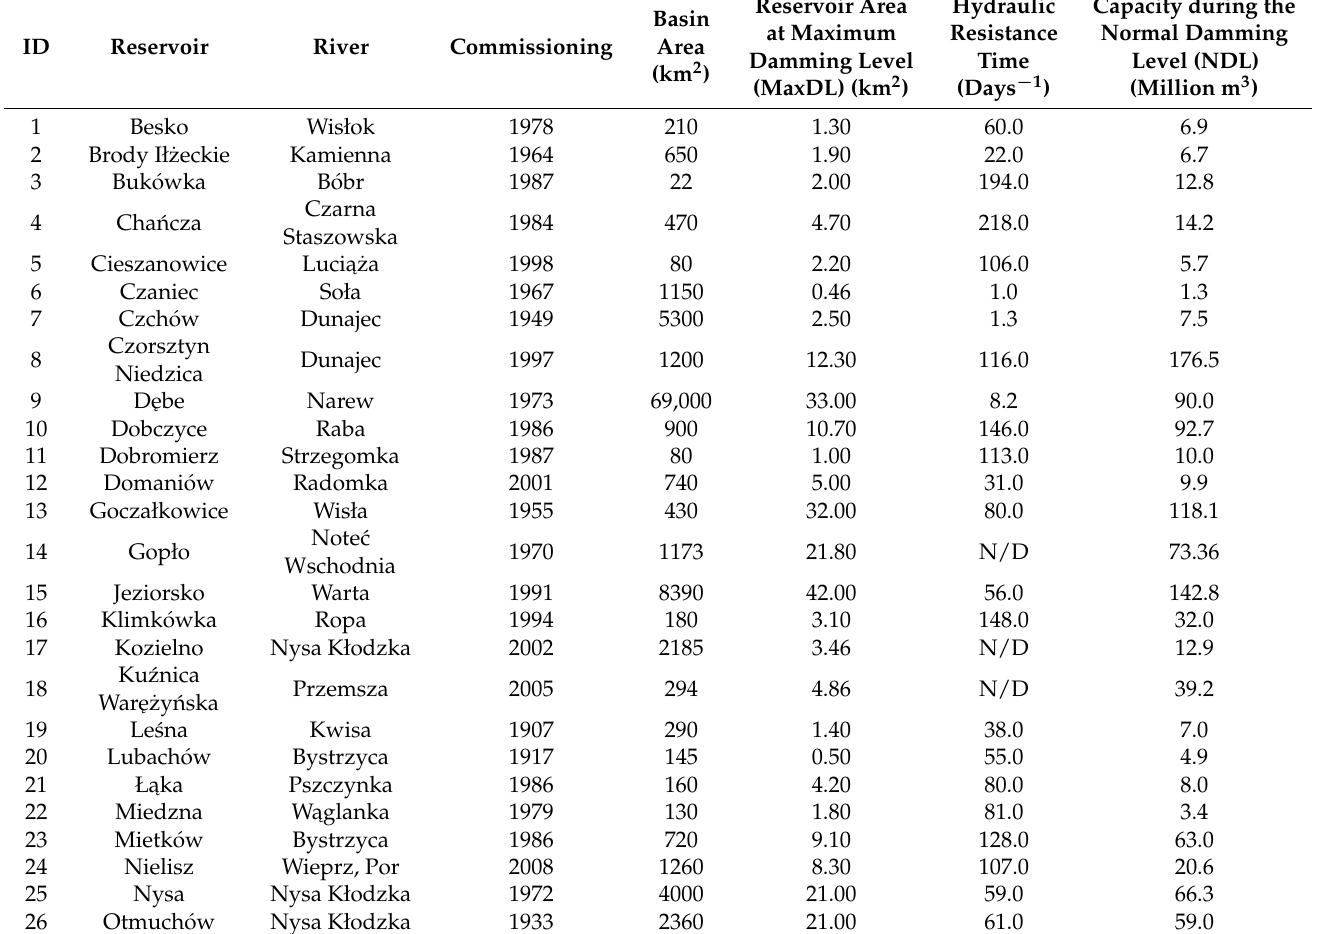
Table A1. Basic parameters of reservoirs crucial for water management in